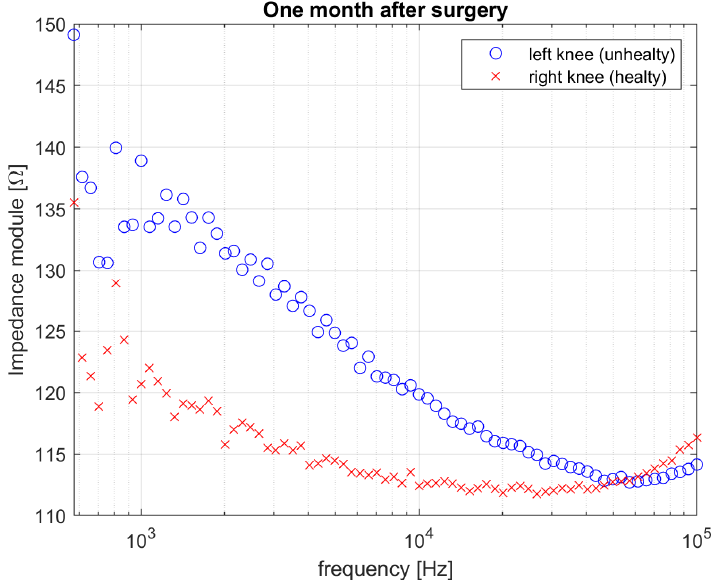
Figure 8. Impedance magnitude value for both right (healthy) and left (unhealthy) knee one month after surgery.